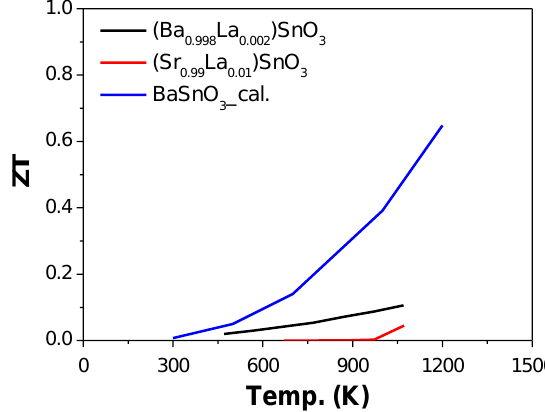
Figure 10. ZT value of ASnO 3 based oxide perovskite materials, all the materials are n-type semiconductors. The symbol “cal.” means the results come from the calculation.